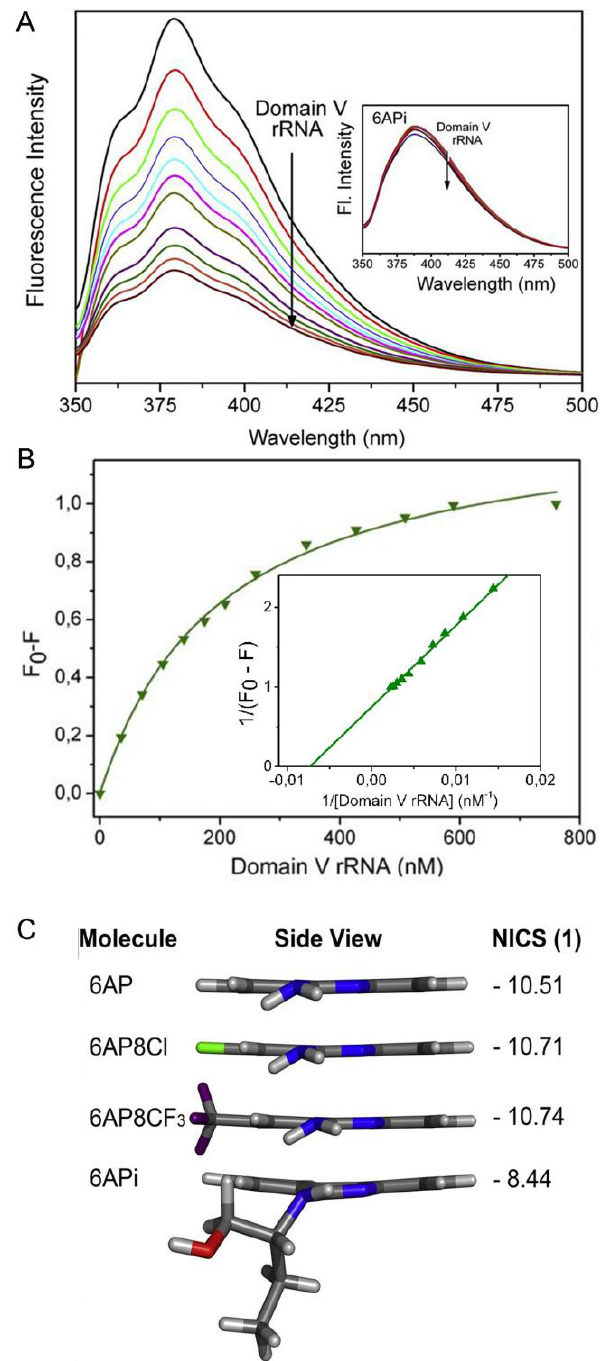
Figure 5. ( A ) Quenching of 6AP fluorescence in the presence of domain V rRNA. Inset shows 6APi fluorescence, which does not quench by addition of domain V rRNA; ( B ) Saturation binding curve of 6AP with domain V rRNA. The double reciprocal plot of the binding curve is in the inset, the K value is determined from the reciprocal of the D X-intercept; ( C ) Lateral view of the 6AP derivatives and corresponding values of Nucleus independent chemical shift (NICS). The figure is reproduced with permission from [45]